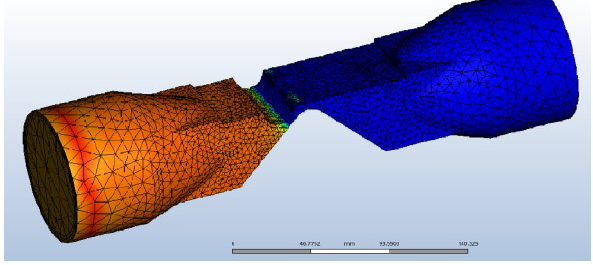
Fig. 4. Volume mesh model.